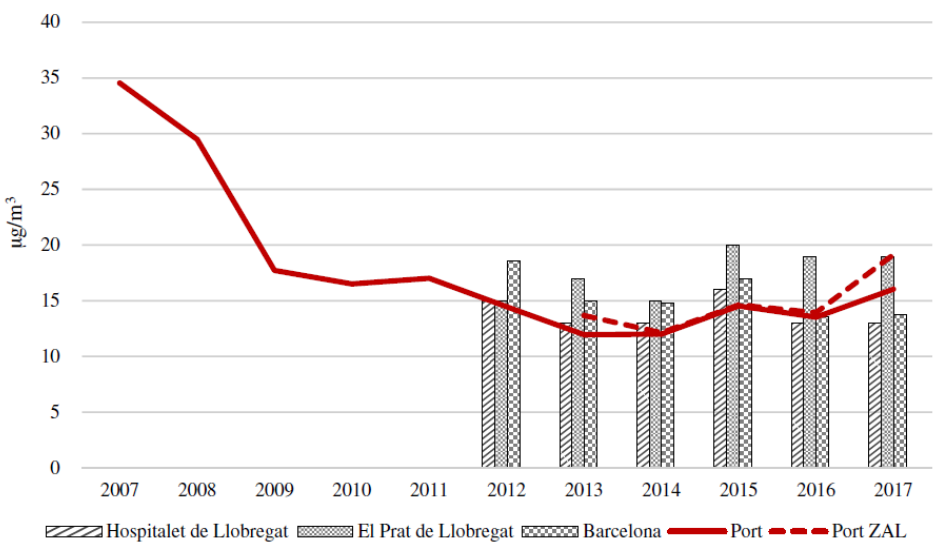
Figure 9. Annual mean of PM 2.5 emissions between 2007 and 2017, showing an overall decreasing trend. Reprinted with permission from ref. [44]. Copyright © 2020 Elsevier Ltd. All rights reserved.